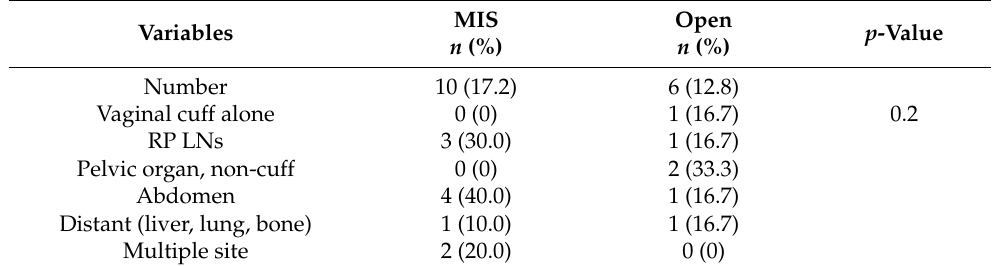
Table 3. Sites of recurrence.